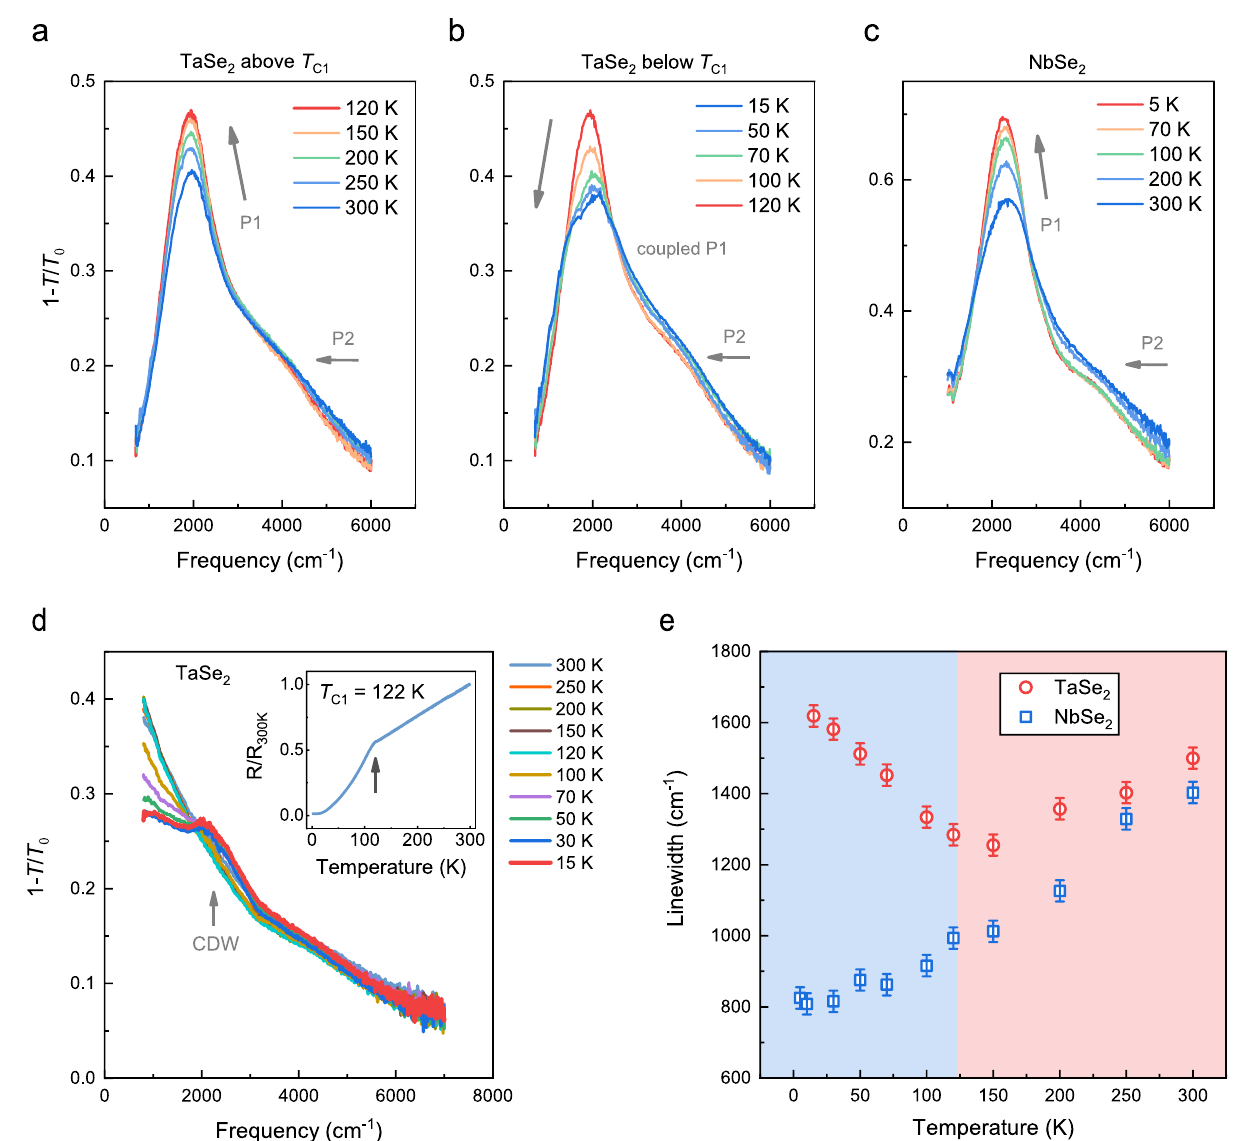
Fig. 4 The temperature dependence of 2H-TaSe 2 and 2H-NbSe 2 plasmons. a The temperature evolution of the plasmon spectra of 2H-TaSe 2 (sample T4, W = 700 nm, d = 20 nm) above T T W = 700 nm, C1 . b Same as a but below C1 . c The temperature-dependent plasmon spectra of 2H-NbSe 2 (sample N1, d = 25 nm). The arrows in a – c beside the main peaks indicate the peak height evolution with decreasing temperature, P1 and P2 denote the fi rst-order and the second-order plasmons, respectively. d The extinction spectra of 2H-TaSe 2 with light polarized along the ribbon direction at various temperatures. The CDW excitation appears with temperature below T C1 . The inset shows the normalized temperature-dependent resistivity of a TaSe 2 thin fi lm ( d ≈ 20 nm). e The fi tted temperature-dependent peak widths of TaSe 2 and NbSe 2 plasmons (the fi rst order), the error bars show the uncertainty of spectral fi tting. The pink and blue backgrounds denote the normal metal and CDW phases of 2H-TaSe 2 ,